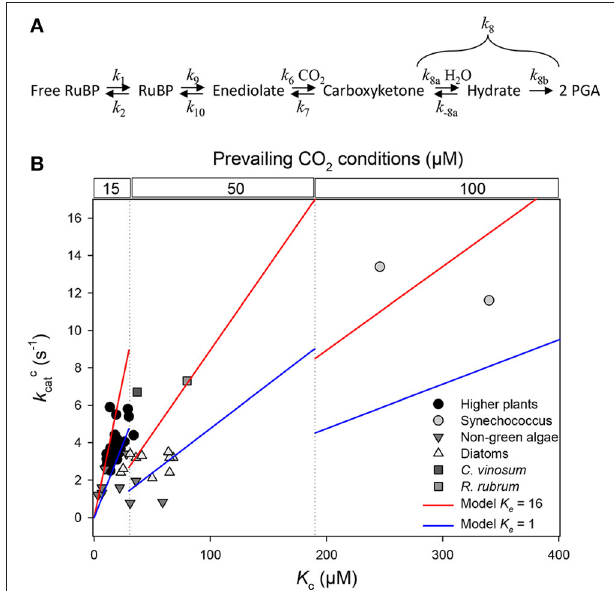
FIGURE 1 | Relationship between Rubisco’s turn-over rate for carboxylation ( k c cat ) and the apparent Michaelis constant for CO 2 ( K c ) using the same dataset tabulated by (Cummins et al., 2018). (A) Formal representation of the mechanism for carboxylation, with rate constants mentioned in main text. (B) Representation of k c cat against K c using a linear scale on both axes. Steady-state kinetics are so that k c cat = K c · k 6 · c · K e /[(1 + c ) · (1 + K e )] where K e is enolization equilibrium constant k 9 / k 10 and c is commitment to catalysis k 8 / k 7 (Farquhar, 1979). It should be noted that k 6 is not in s − 1 but in µ M − 1 s − 1 and thus not on the same scale for all organisms since it depends on prevailing subcellular CO 2 concentration. The two linear models shown (blue and red lines) represent numerical examples of the relationship and assume that k 6 · [CO 2 ] is fixed at 5 s − 1 while k 6 is subdivided into three domains of prevailing CO 2 conditions varying with K c (10, 50 and 100 µ M). Calculations assume that enolization is efficient ( K e = 16, red) or poor ( K e = 1, blue) and that the commitment to catalysis is c = 95/5 = 19 ( Lorimer et al.,